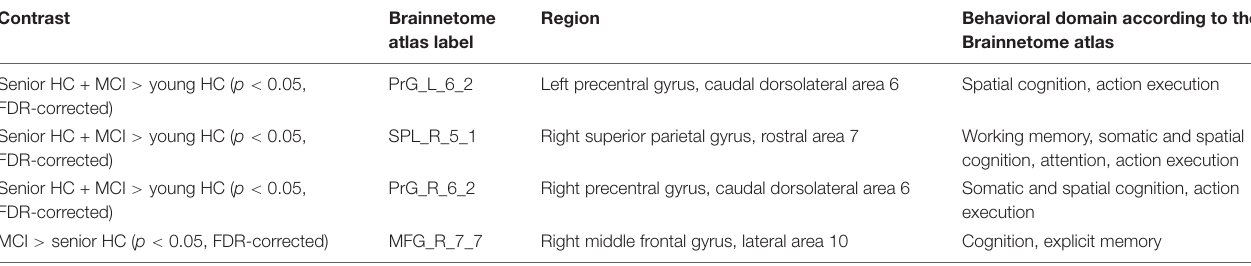
TABLE 2 | The coordinates of the ROIs with a significant increase of DC in the intergroup contrasts.